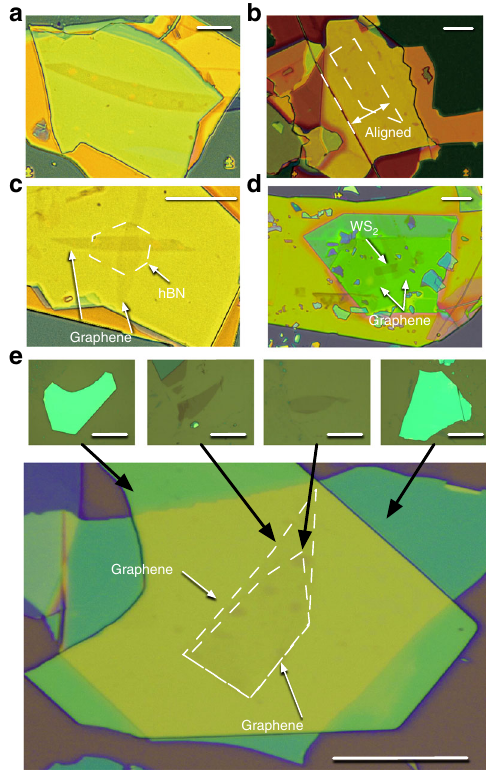
Fig. 3 Optical microscope images of the vdW heterostructures fabricated by using the system. a Optical microscope images of trilayer graphene encapsulated in hBN. b Monolayer graphene with crystallographic axes aligned to those of hBN (indicated by white dashed lines). c hBN vertical tunneling structure. d hBN-encapsulated WS 2 , which was contacted by trilayer graphene, where the scale bars represent 10 µ m. e Bottom panel: Twisted monolayer – bilayer graphene encapsulated in hBN. Top panel, left to right: hBN, graphene, bilayer graphene, and hBN utilized to assemble the twisted monolayer – bilayer graphene, where the black arrows indicate the correspondence between images, and the white dashed lines indicate the graphene edges. The scale bar represents 10 μ